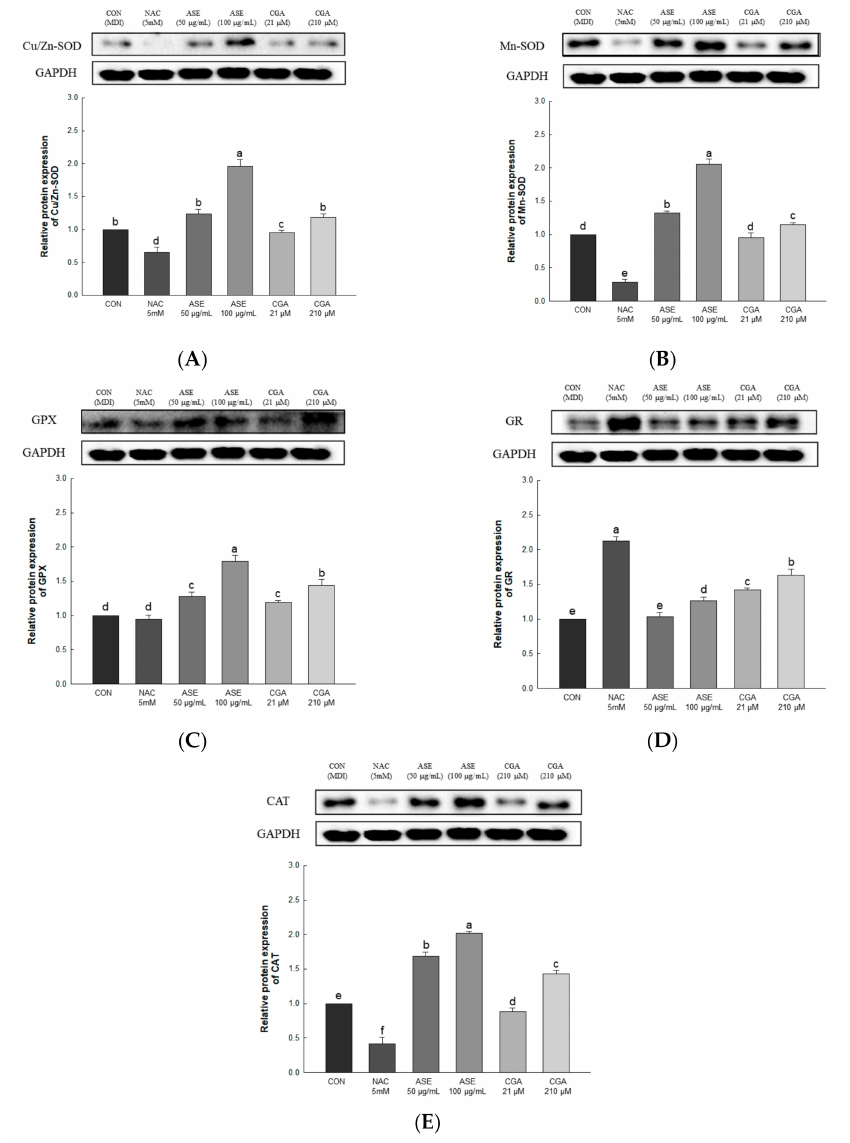
Figure 7. E ff ects of ASE and CGA on the expression level of ROS regulation antioxidant enzyme in 3T3-L1 adipocyte. Protein expression of Cu / Zn-SOD ( A ), Mn-SOD( B ), GPX ( C ), GR ( D ) and CAT ( E ). 3T3-L1 adipocytes di ff erentiated for 6 days were treated with ASE (50 and 100 µ g / mL) and CGA (21 and 210 µ M). Protein expression was quantified through western blotting and normalized through GAPDH expression level. Each value is expressed as the mean ± SD of triple determination. The other letters on the bars indicate a significant di ff erence of p < 0.05 in the Duncan multi-range test. a–f significant di ff erences among various parts of